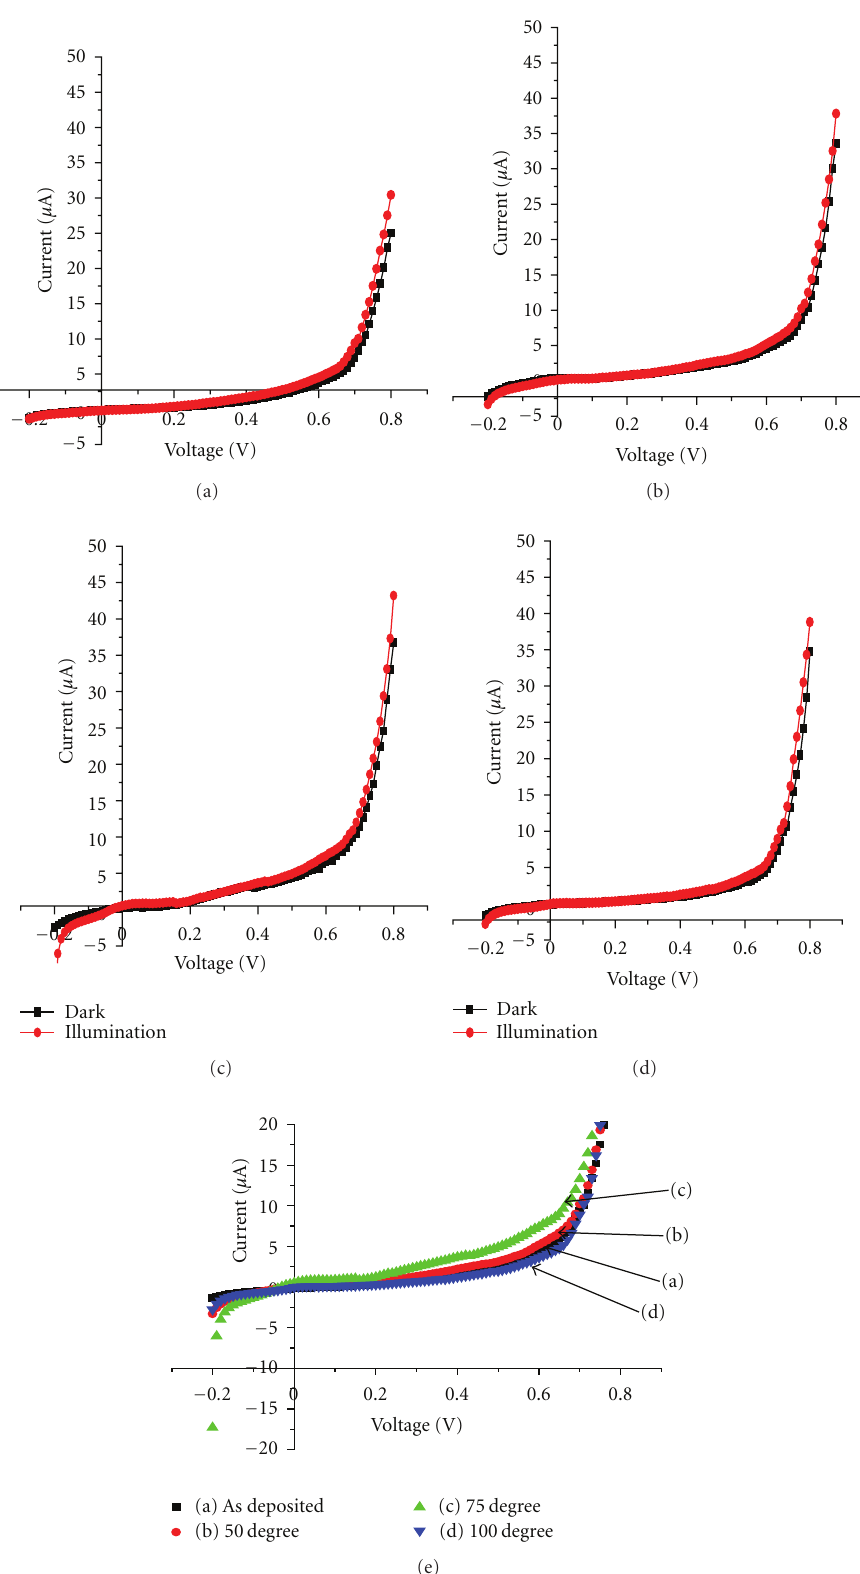
Figure 2: I-V for organic solar cells with di ff erent thermal treatment: (a) S 0 , (b) S 50 , (c) S 75 , (d) S 100 , and (e) comparison for I-V under illumination for (nanocomposited MEH-PPV:CNTs as deposited, 50 ◦ C, 75 ◦ C, and 100 ◦